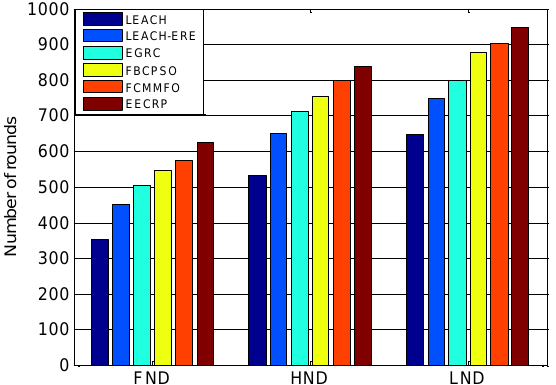
Figure 10. The number of rounds when FND (first node dead), HND (half of the nodes dead), and LND (last node dead) arise for different protocols.